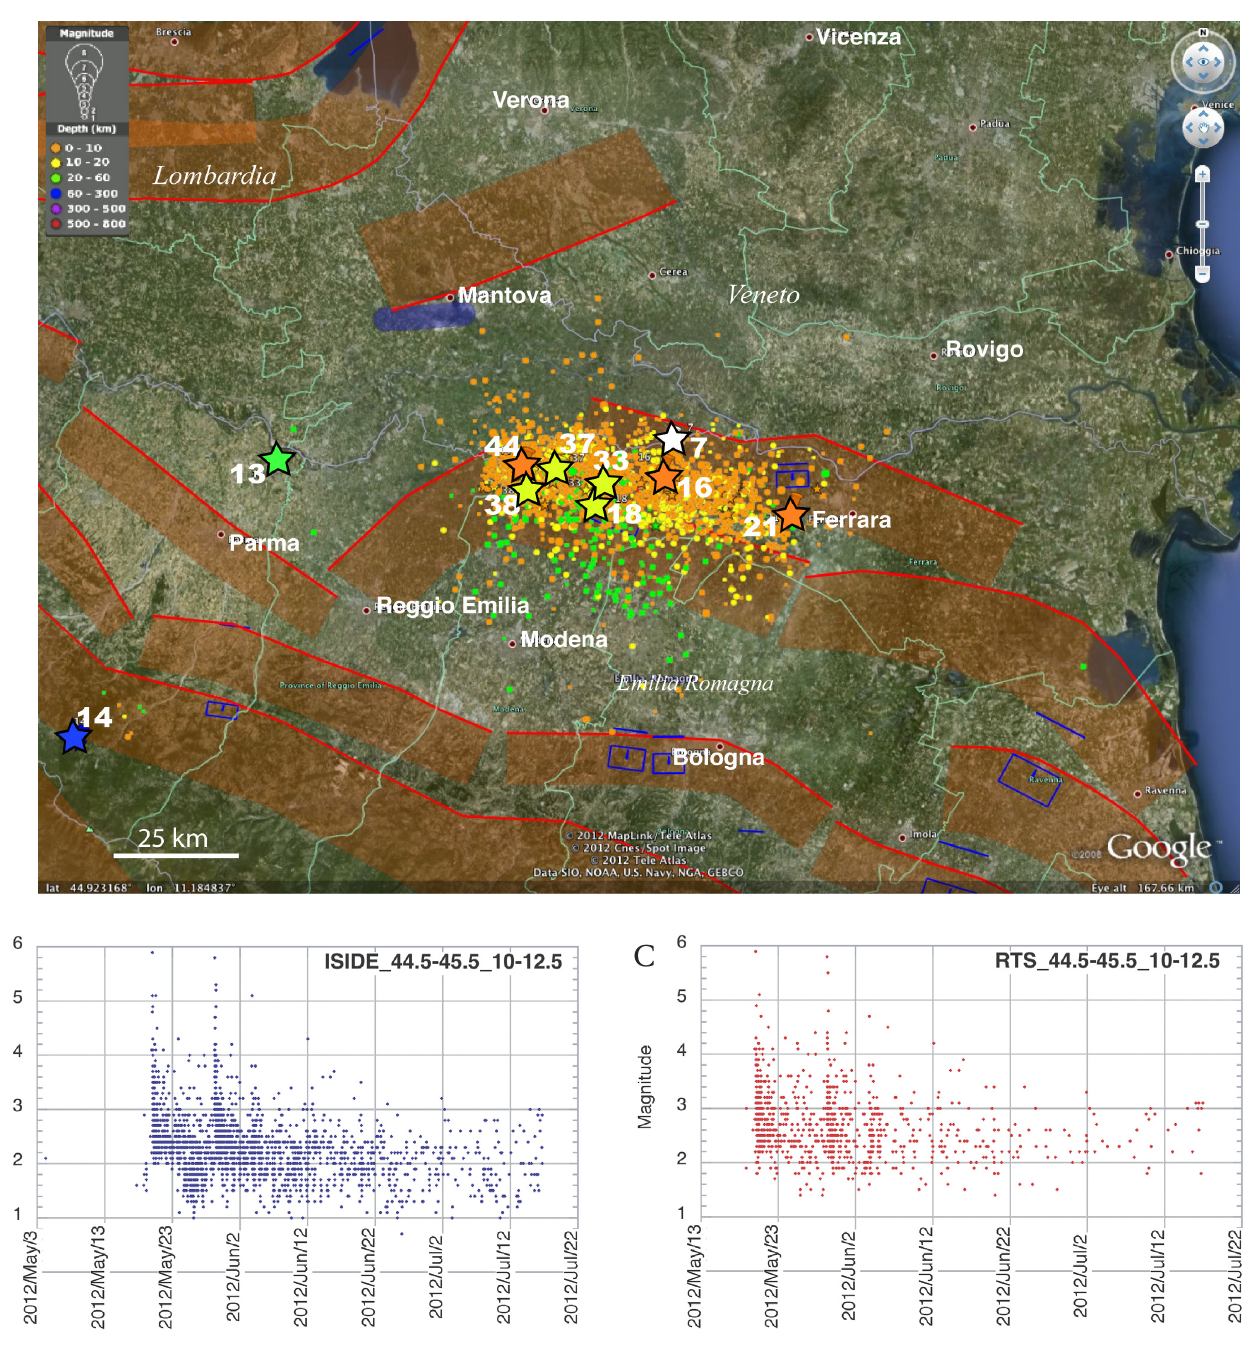
Figure 1. A. Instrumental seismicity (dots and stars) for the Po Plain, from May 1, 2012, to July 16, 2012, located inside a rectangular area of latitude 44.5- >4.6 events, numbered as in Table 1, modelled as source faults in the Coulomb analy- 45.5 ˚N, longitude 10.0-12.5 ˚E. Locations are from ISIDe. Stars, M W sis. Orange shaded area, DISS 3.1.1 composite sources; blue rectangles, individual sources; bluish areas, debated sources. B. Magnitude versus time for the Emilia sequence, by INGV (ISIDe). C. As for (B), as reported by the OGS (RTS) databases. The ISIDe data are manually revised locations (2,277 events, 656 with M ≥ 2.5; data); the RTS data are mostly automatic solutions (946 events, 578 with M ≥ 2.5;). All of the locations are preliminary, as on July 17,